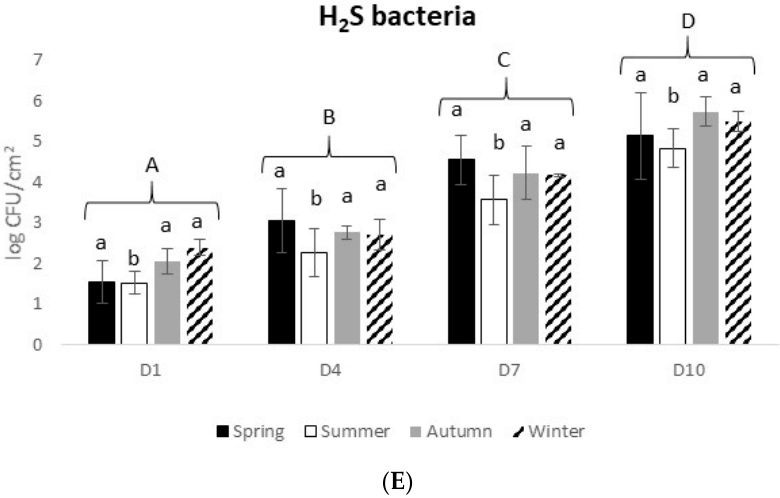
Figure 3. Seasonal Atlantic horse mackerel freshness profile over 10 days on ice, assessed by different methods: ( A ) Quality Index Method, ( B ) EC scheme, ( C ) Torrymeter (TRM), ( D ) microbiology (TVC), and ( E ) microbiology (H 2 S-producing bacteria). Values represent mean ± SD ( n = 6). In Figure 3D,E, different uppercase letters indicate significant differences among days, while different lowercase letters indicate significant differences among seasons. In the other figures, different letters indicate significant differences among treatments.